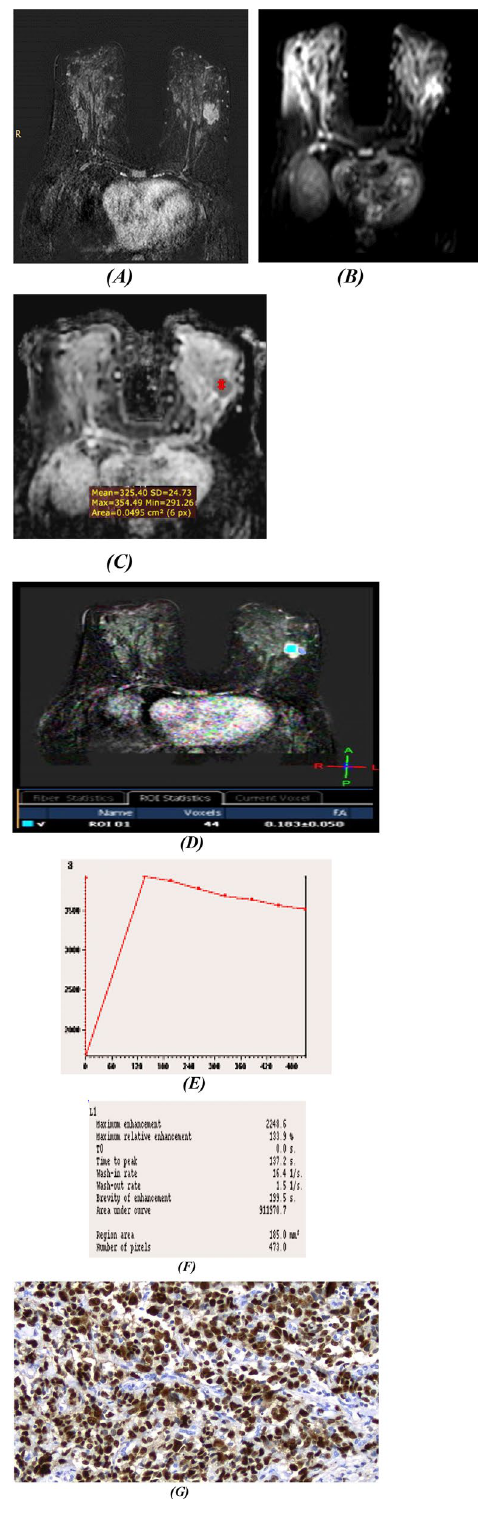
Fig. 1 Female patient aged 42 years old presented by palpable left breast mass. A Axial early subtraction MR image shows irregular shaped soft tissue mass with speculated margin and heterogeneous enhancement within the lower outer quadrant of the left breast. B, C Axial DWI and ADC show high SI in DWI and low SI on ADC map (restricted diffusion) with mean ADC value D Axial DTI image shows FA value 0.18. E, F Time intensity curve shows Type III curve (wash out curve) with maximum enhancement 2248.6, Time to peak 137.2swith wash out ratio 1.5 s. G Pathological diagnosis was grade III invasive ductal carcinoma luminal B her2 positive (ER and PR positive with high Ki‑67 index (Ki‑67 HER2‑positive)